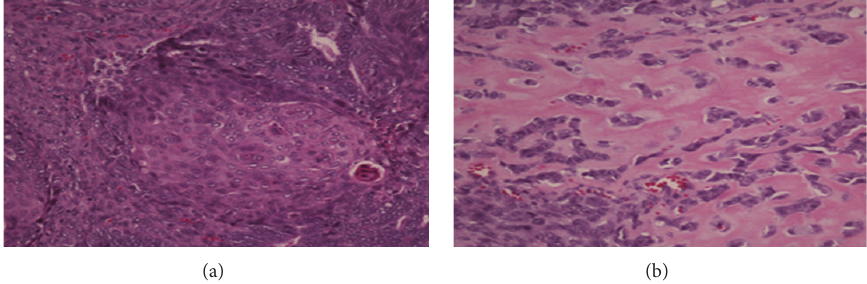
Figure 5: (a) (20x) H&E: showing squamous differentiation; (b) (20x) H&E: high power of malignant